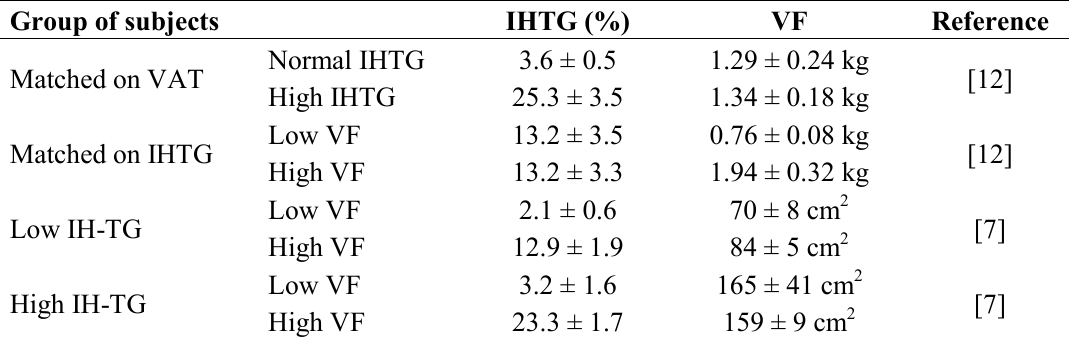
Table 1. Hepatic and visceral fat in subjects matched for VF or IHTG (data from [12]) or when matched for low or high IHTG (data from [7]).